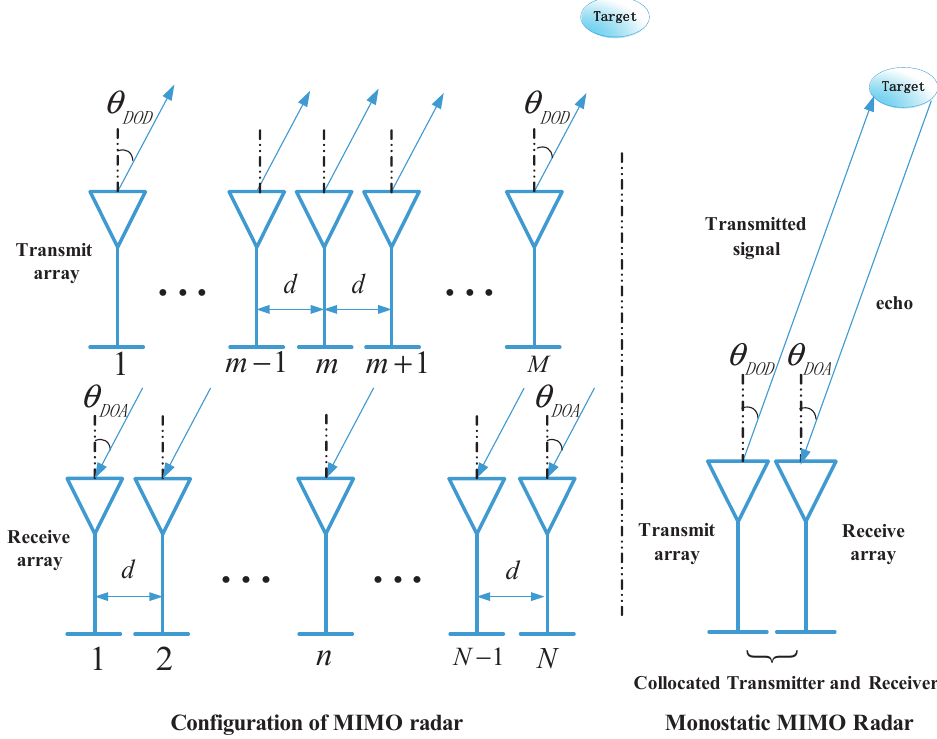
Figure 1. Configuration of monostatic multiple-input multiple-output